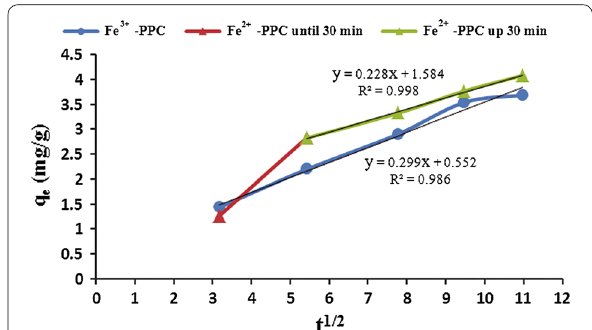
Fig. 6 Diffusion kinetic models for Pb 2 + adsorption. The Morris Weber model kinetic were don’t in various times. This model for Fe 2 + -PPC is depicted in blue. The Morris Weber model in the range of 0–30 min for Fe 3 + -PPC is depicted in red and in the range of 30–60 min is depicted in green